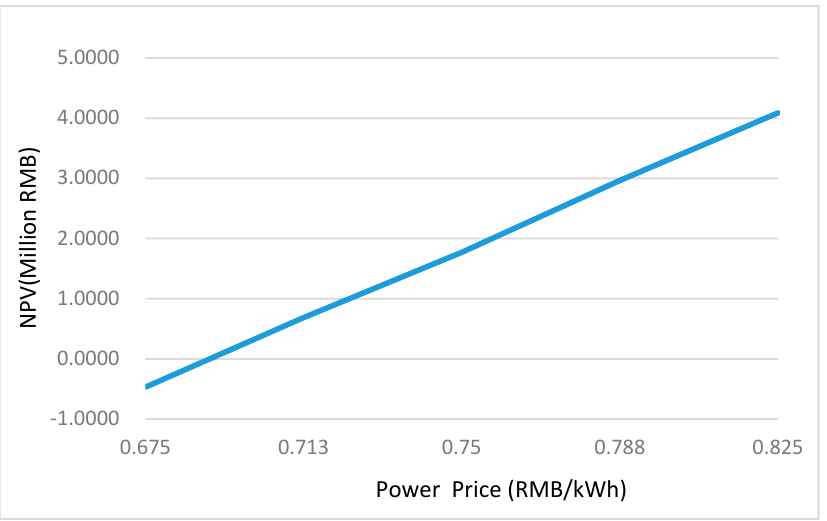
Figure 9. Electricity price as a function of NPV.